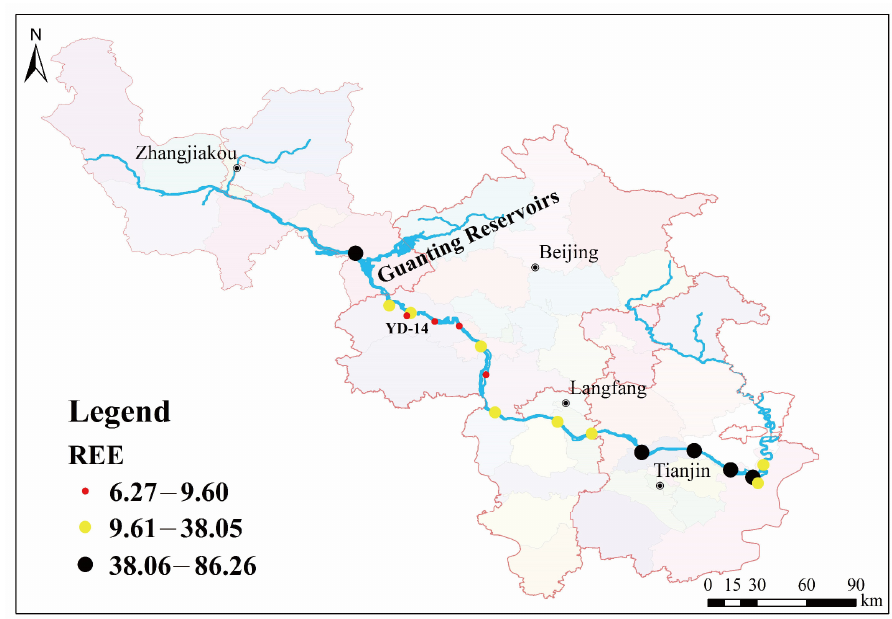
Figure 2. Spatial distribution of the total REEs content in the Yongding River.